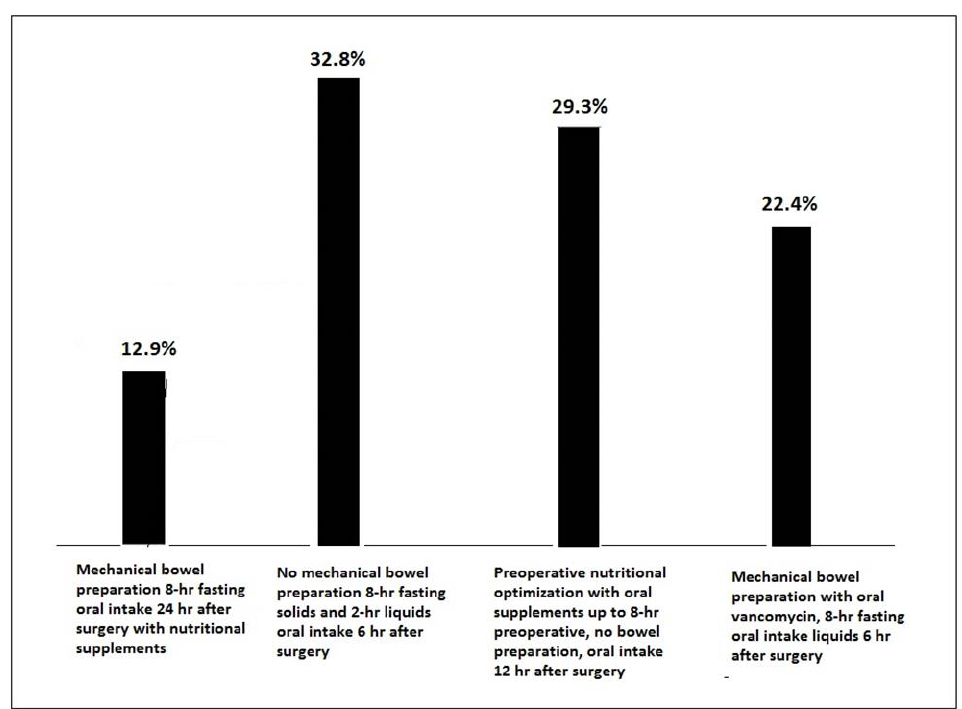
Figure 2. Preoperative recommendations in the use of an ERAS protocol for a patient with sigmoid rectal cancer (hr: